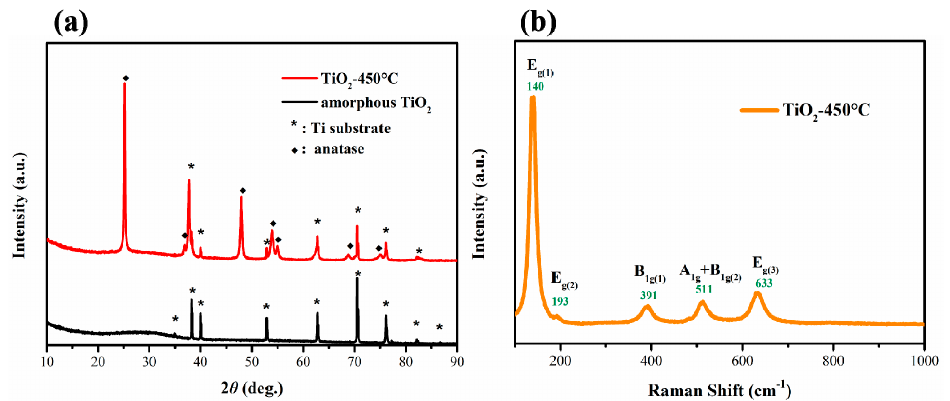
Figure 4. ( a ) XRD patterns of amorphous TiO 2 -20 h and anatase TiO 2 -20 h-450 ◦ C. ( b ) Raman spectra of anatase TiO 2 nanotubes after annealing. The samples were synthesized in electrolyte with 0.5 wt% NH 4 F and with anodization oxidation time of 20 h.